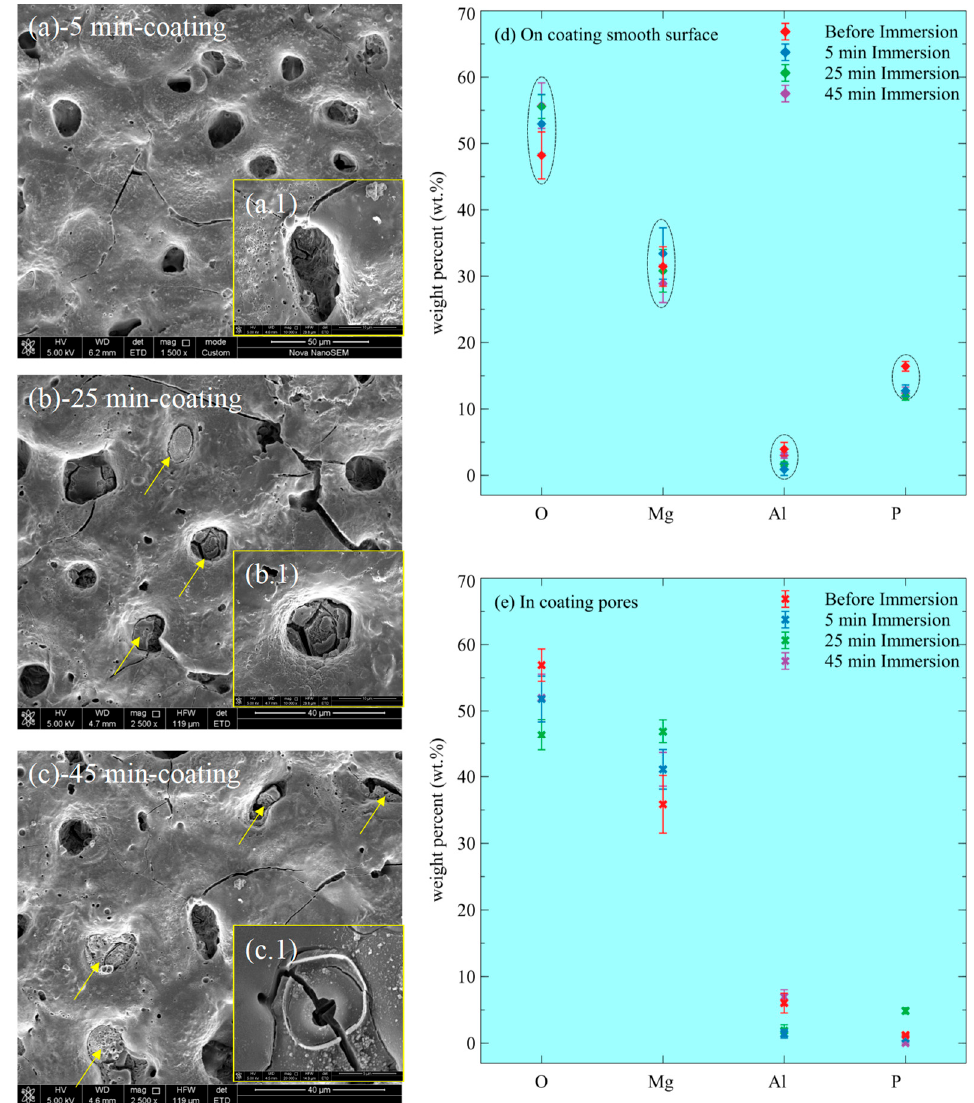
Figure 8. Elemental compositions of corrosion products of AZ91 alloy and MAO-coated alloy at different immersion times in a 3.5% NaCl solution. ( a – c ) the coating surface morphology after 5, 25, and 45 min immersion; (a.1–c.1) the localized corrosion morphology; ( d ) the weight percent (wt.%) of the elements on the smooth corroded surface; ( e ) the weight percent (wt.%) of the elements in coating pores.